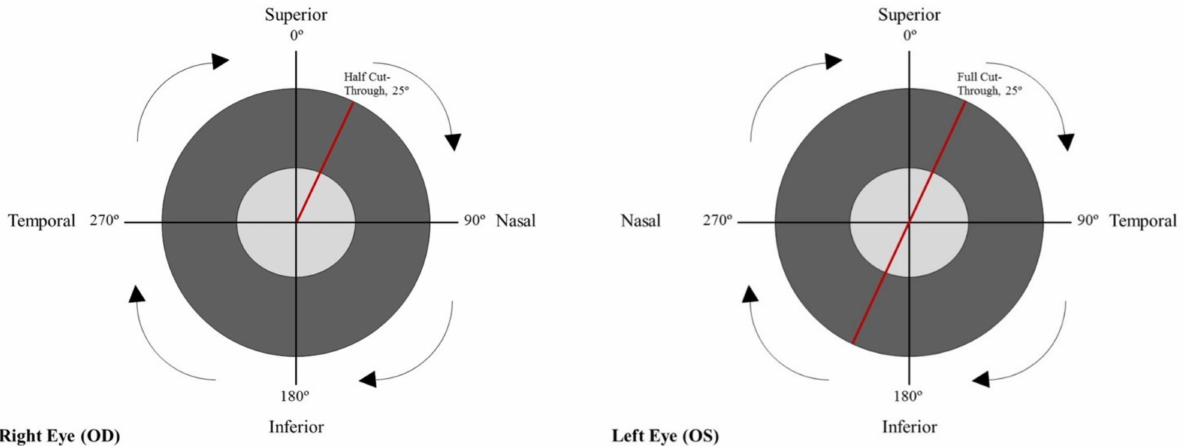
Figure 1. Orientation of degrees in the optic nerve head of right and left